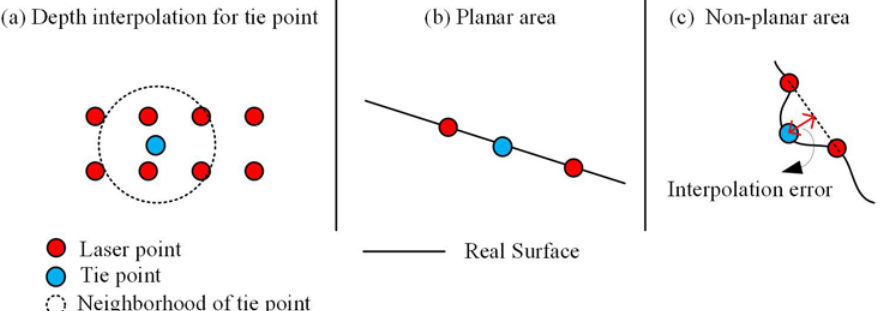
Figure 16. Illustration of attaching tie points with laser depth. ( a ) Depth interpolation for a tie point on the image plane. ( b ) Reliable interpolation in the planar area. ( c ) Unreliable interpolation in the non-planar area.